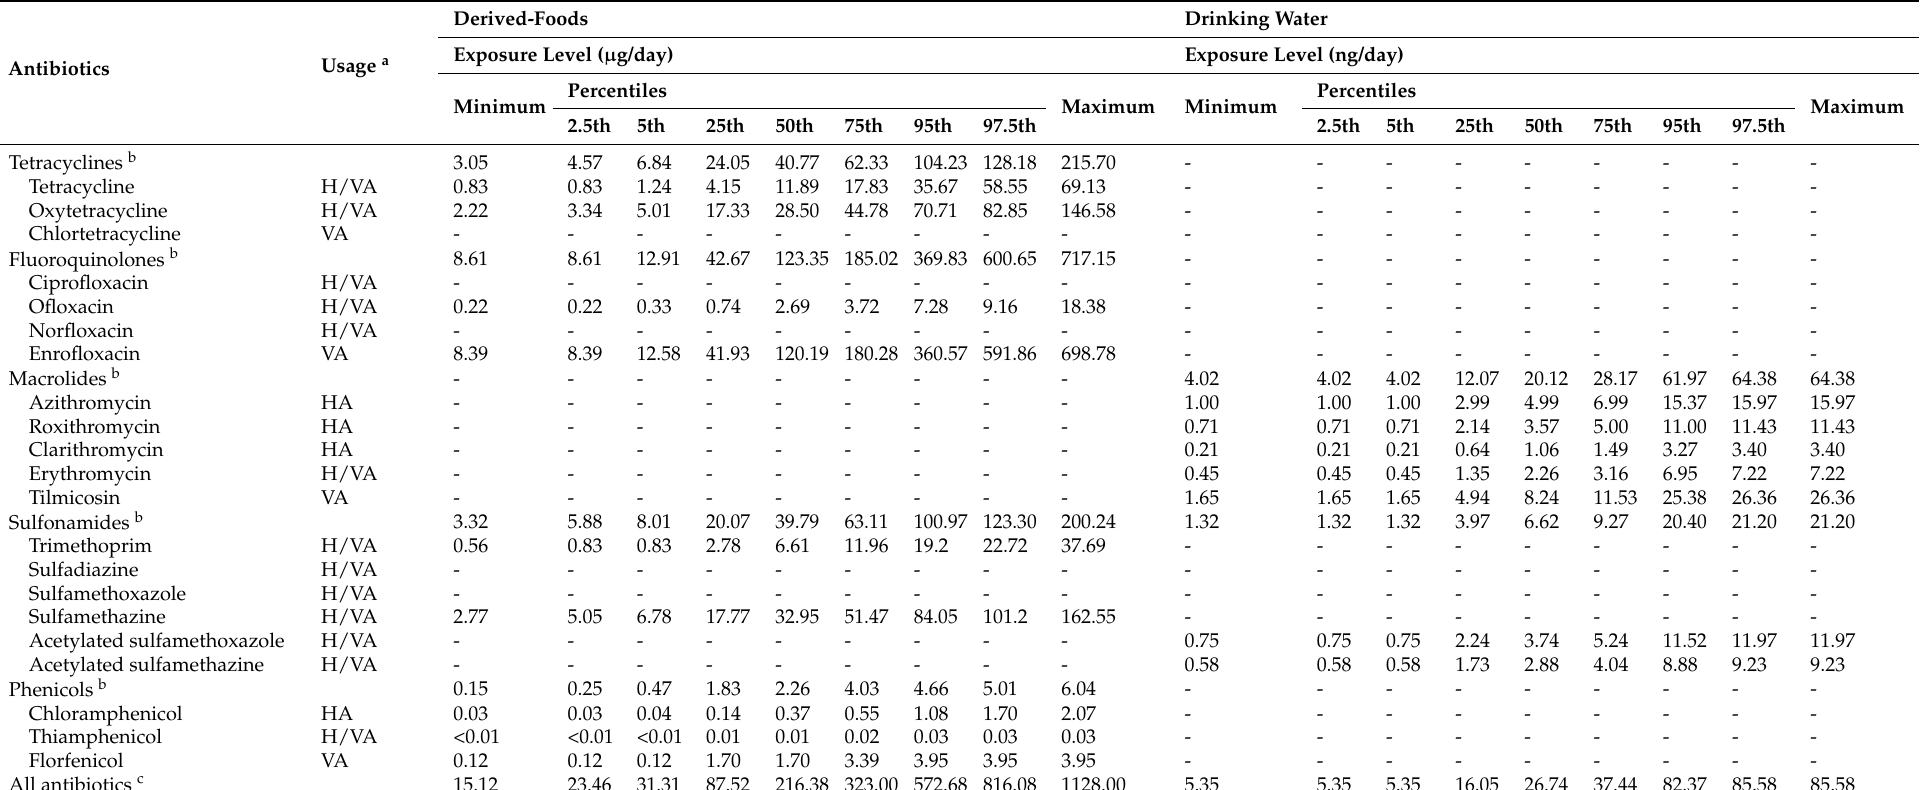
Table 2. Dietary exposure level to antibiotics via animal-derived foods and drinking water among